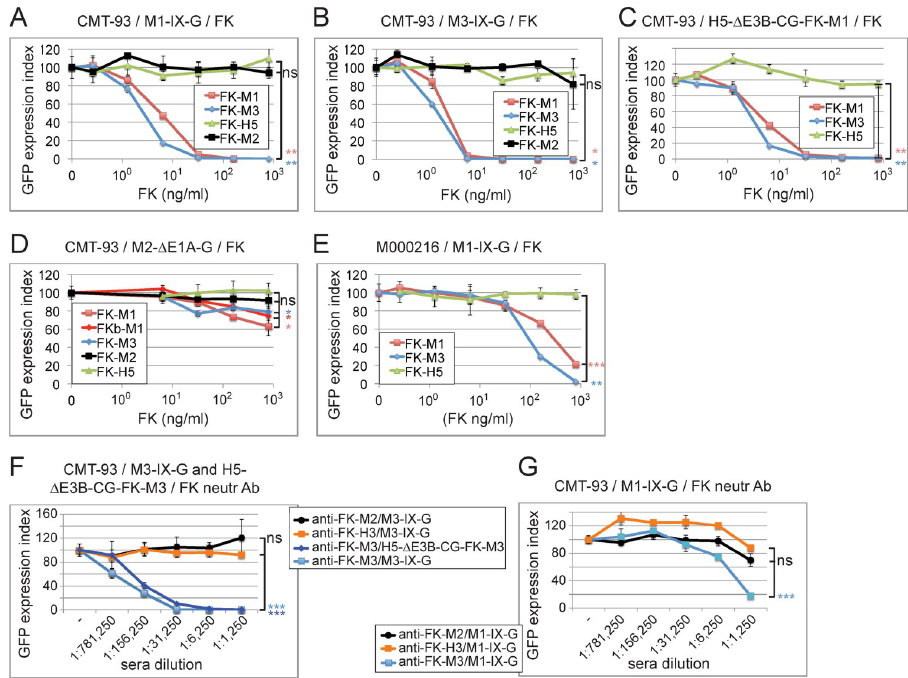
Fig 2. Inhibition of MAdV and fiber-chimeric GFP reporter virus transduction in CMT-93 and M000216 cells by recombinant MAdV FKs and anti-FK antisera. (A-D) CMT-93 cells were incubated for 1 h on ice using 5-fold dilution series of the indicated FK proteins starting with 0.8 μ g/ml as highest concentration, followed by addition of the different GFP-expressing viruses and transfer to 37˚C for 48 h. The virus input amounted to an MOI of 1 and included M1-IX-G (A), M3-IX-G (B), H5- Δ E3B-CG-FK-M1 (C), M2- Δ E1A-G (D). GFP analysis was performed 48 h pi, and expression index was normalized to FK-H3 control protein. (E) M000216 cells were preincubated and processed as described for CMT-93 cells, except that M1-IX-G was used at an MOI of 3. (F) The M3-IX-G and H5- Δ E3B-CG-FK-M3 viruses were pre-incubated for 1 h at RT with serial 5-fold dilutions of the different antisera ranging from 1:1,250 to 1:781,250, followed by addition of the mixes to CMT-93 cells for 48 h at 37˚C. The rabbit antisera tested were raised against recombinant FK-M3, FK-M2 and FK-H3, respectively. The virus input amounted to an MOI of 1, and samples were processed for analysis as described above. (G) To check for cross-neutralization of the rabbit anti-FK-M3 for M1, M1-IX-G was preincubated with serial dilutions of rabbit anti-FK-M3, -FK-M2 and -FK-H3 sera and further processed as described above. For all experiments, data represent triplicates, shown as mean ± SEM. For highest concentrations of FKs and anti-FK sera, asterisks indicate level of significance for comparison of indicated values ( � , P < 0.05; �� , P < 0.005; ��� , P < 0.0005); ns: not significant ( P >